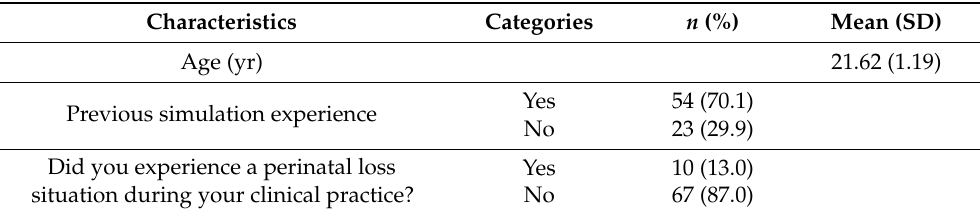
Table 1. Characteristics of participants ( n = 77).